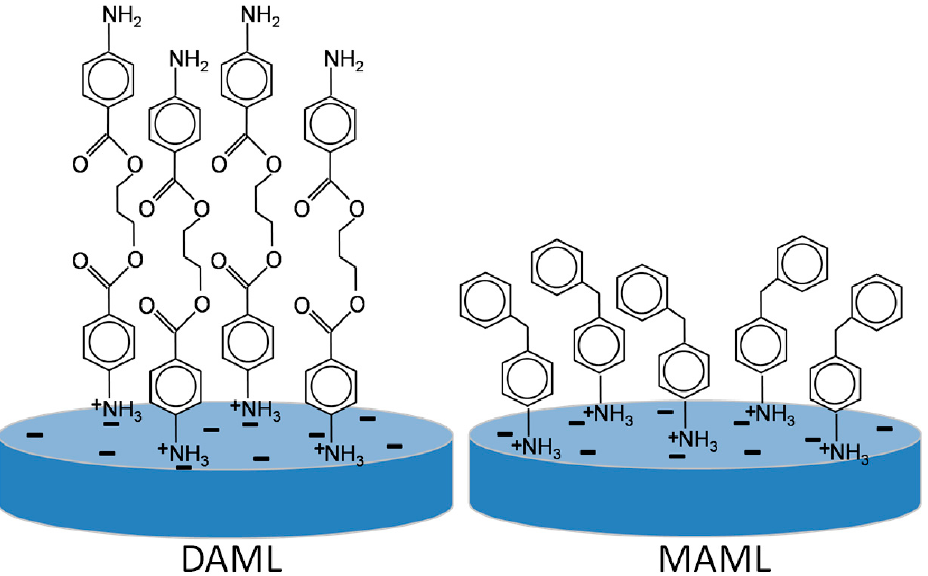
Figure 11. Schematic illustrating the chemical structure of modified Laponite ® s. For simplicity, only one side of modification is